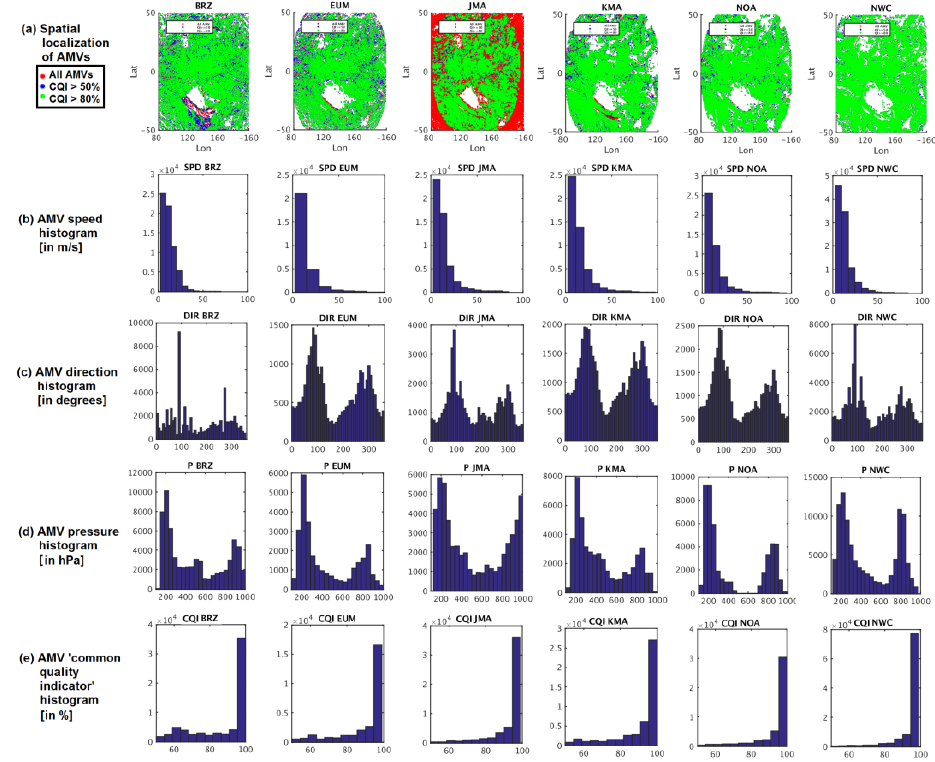
Figure 6. Spatial localization of AMVs ( a ), and histograms of parameters: ( b ) AMV speed in m s − 1 , ( c ) AMV direction in degrees, ( d ) AMV pressure in hPa, ( e ) AMV CQI in %, for the AMV datasets in Experiment 2 with CQI >= 50%. From left to right, BRZ, EUM, JMA, KMA, NOA, NWC.